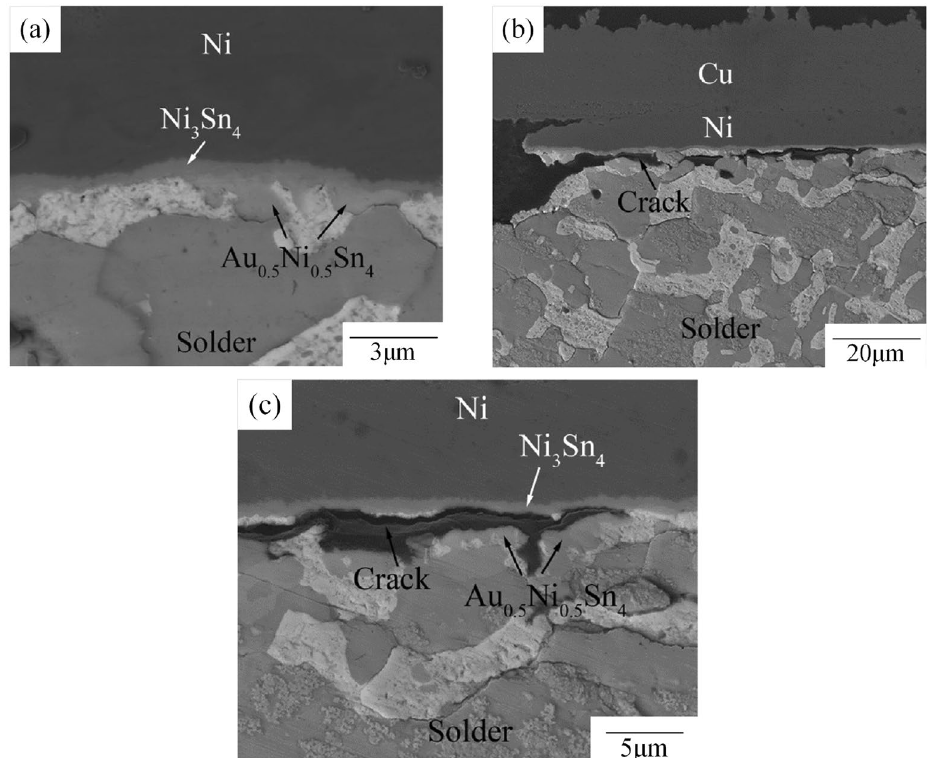
Figure 1 Schematic diagram of IMC cracks and its mechanism at the interface [8]: ( a )–( c ) Cross-sectional SEM micrographs of Sn37Pb solder joints after 300